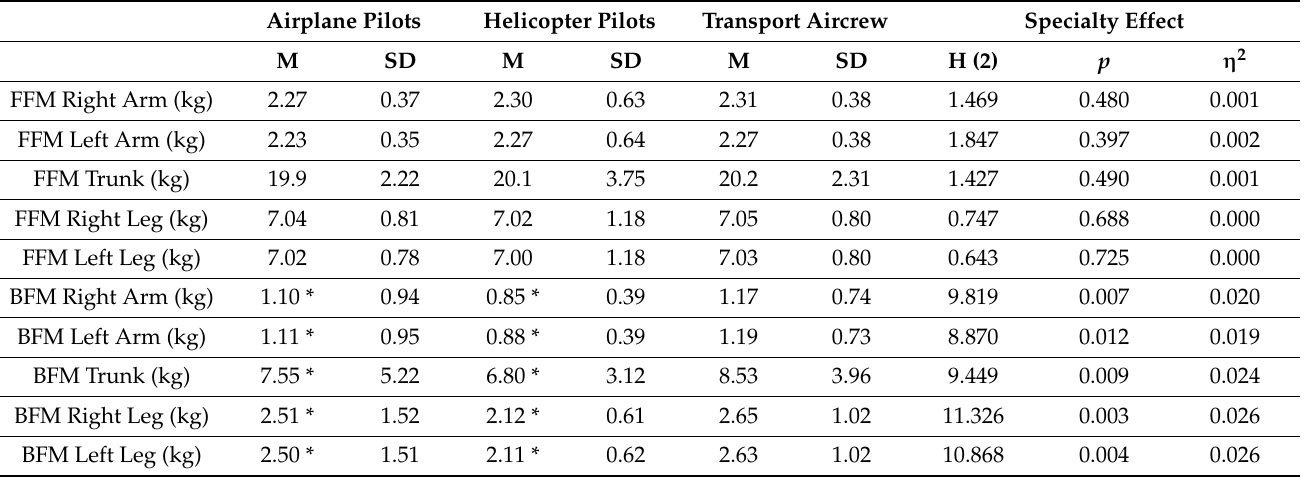
Table 2 shows the results of FFM and BFM by body segments. There was a significant difference between specialties in the body fat mass of the right arm, left arm, trunk, right leg, and left leg. Airplane pilots and helicopter pilots had less body fat mass ( p < 0.05) than transport aircrew in all cases. No significant differences were found for the FFM values by segments. Table 2. Results of fat-free ass and body fat mass by body